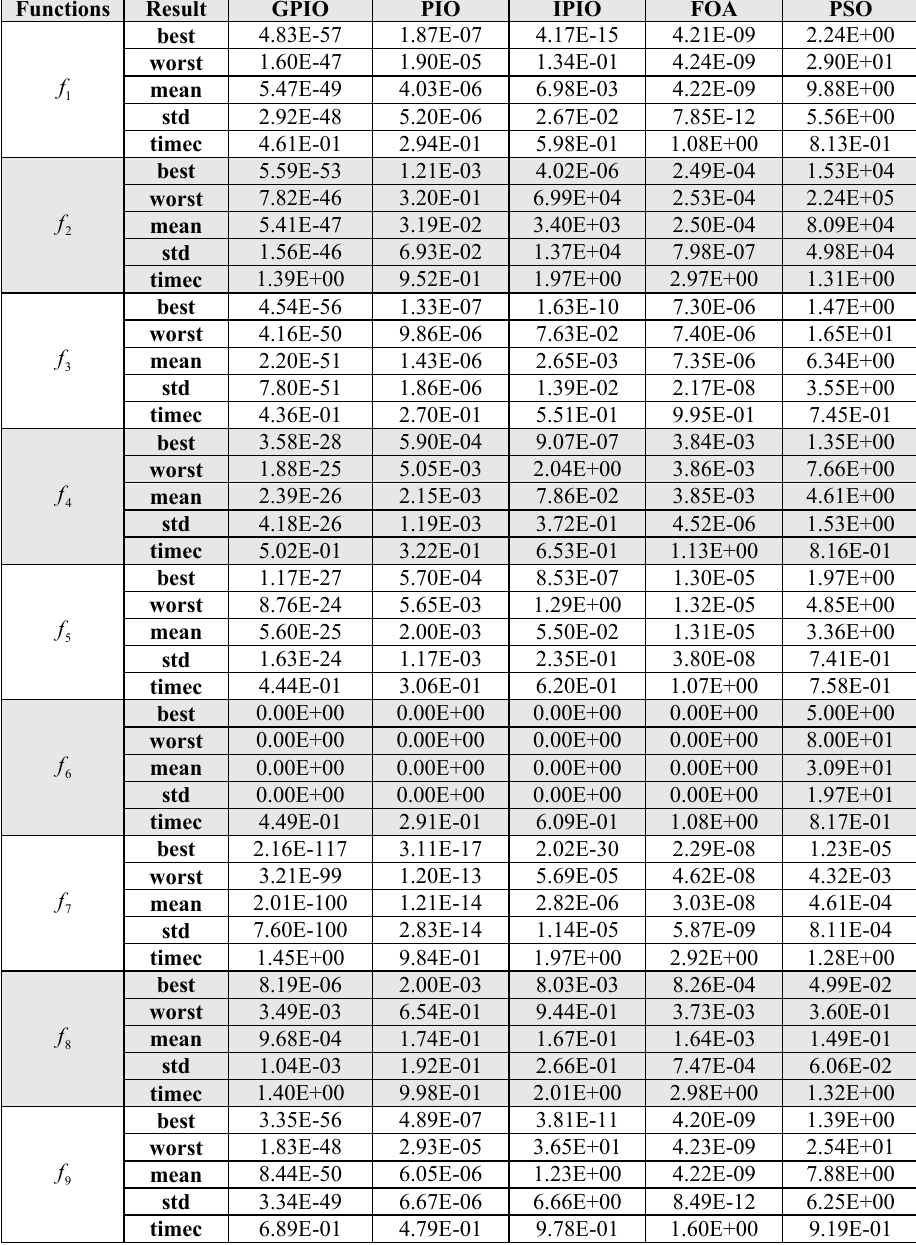
Table 2. Test results of high dimensional single-mode